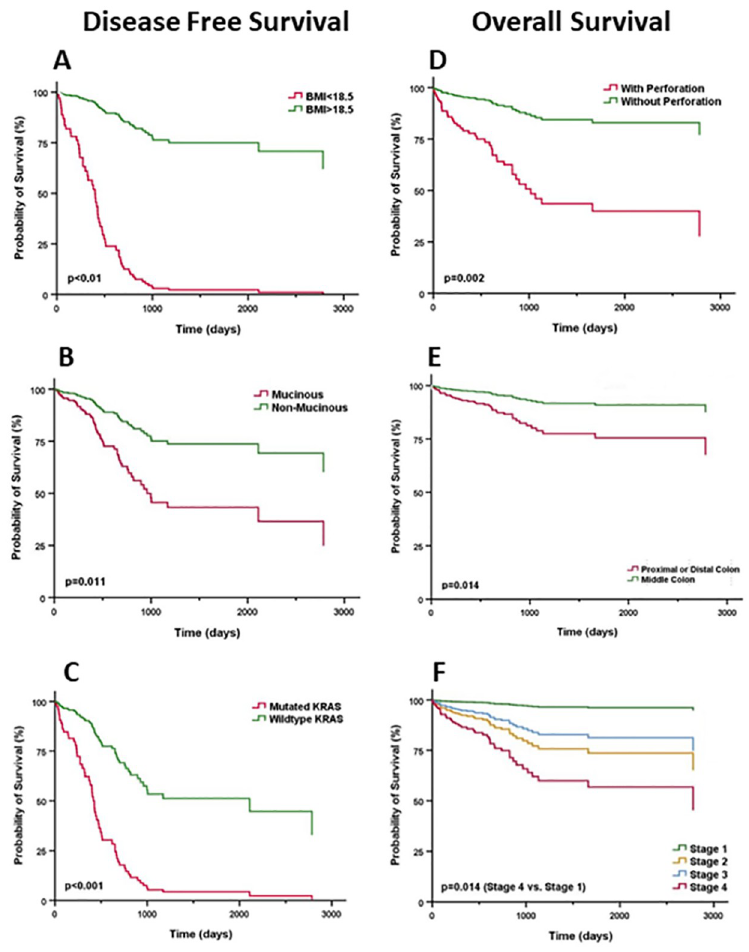
Fig 2. Impact of biological variables on survival of African American patients with CRC. A-C. Disease free survival relative to BMI (A), histologic type (B), and KRAS mutation (C). D-F. Overall survival relative to intestinal perforation (D), tumor location (E), and tumor stage